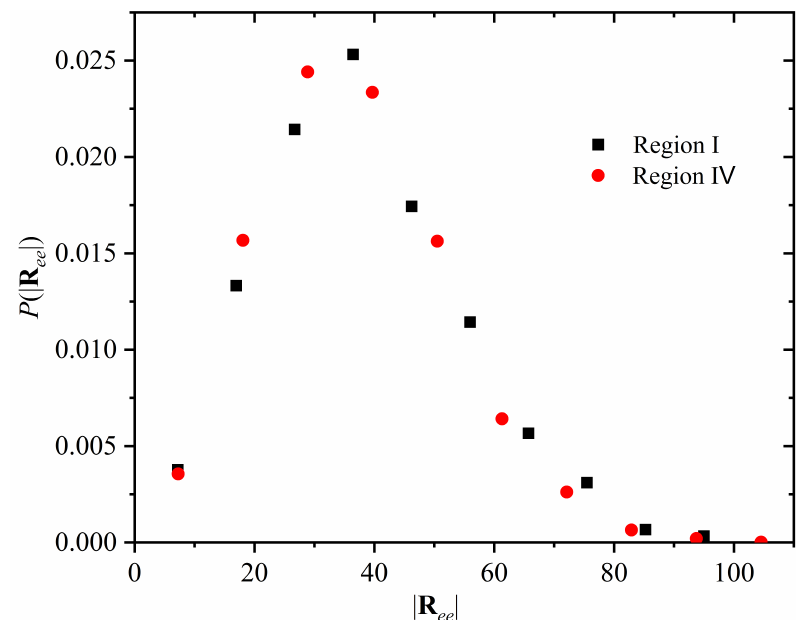
Figure 5. Probability distribution of the modulus of the end-to-end vector, P ( | R ee | ) , for chains in the length interval l ∈ [ 970,1030 ] in the disordered solid (Region I) and in the almost perfect FCC crystal (Region IV). A small interval of l instead of single values of l has been used to obtain better